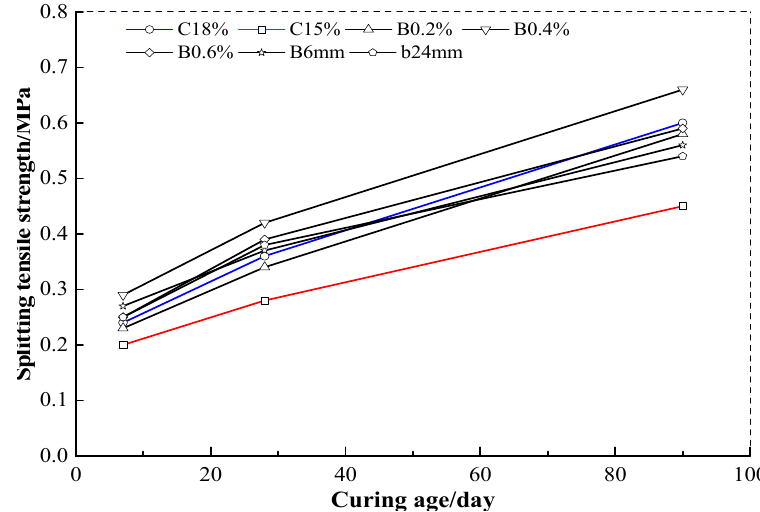
Figure 6. The splitting tensile strength changes of cement soil with different mixture design.